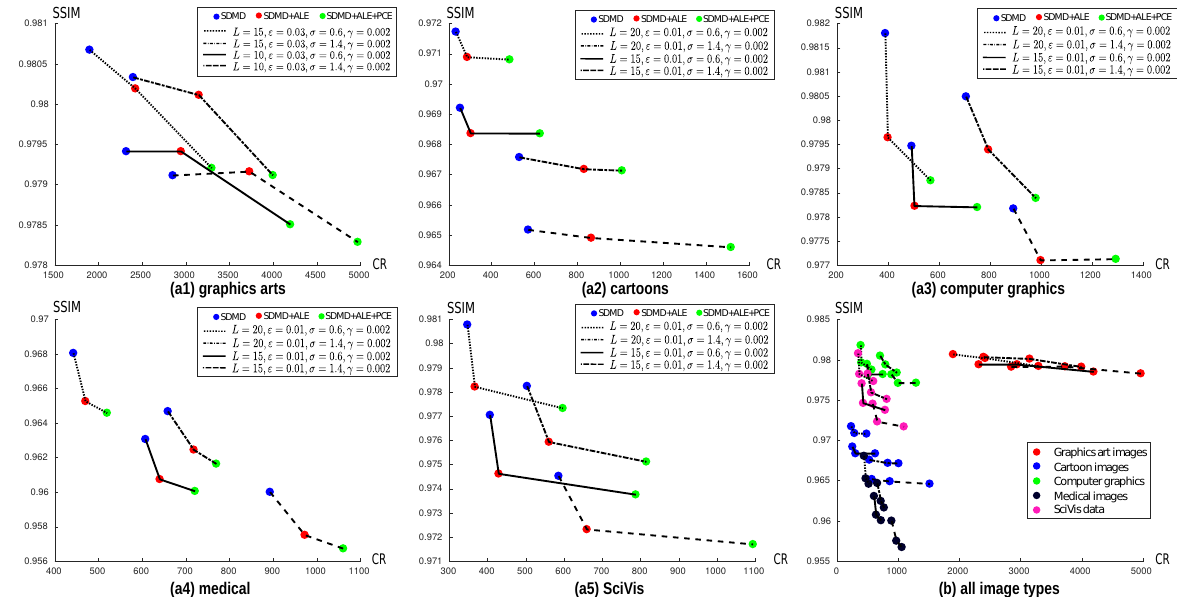
Figure 10. The average SSIM vs. CR for basic SDMD (blue dots), SDMD with adaptive layer encoding (ALE, red dots) and SDMD with both an adaptive layer and per-channel encoding (ALE + PCE, green dots) for graphics art images ( a1 ), cartoon images ( a2 ), computer graphics ( a3 ), medical images ( a4 ), and SciVis images ( a5 ). ( b ) Summarization of the first five plots, with colors indicating image types.